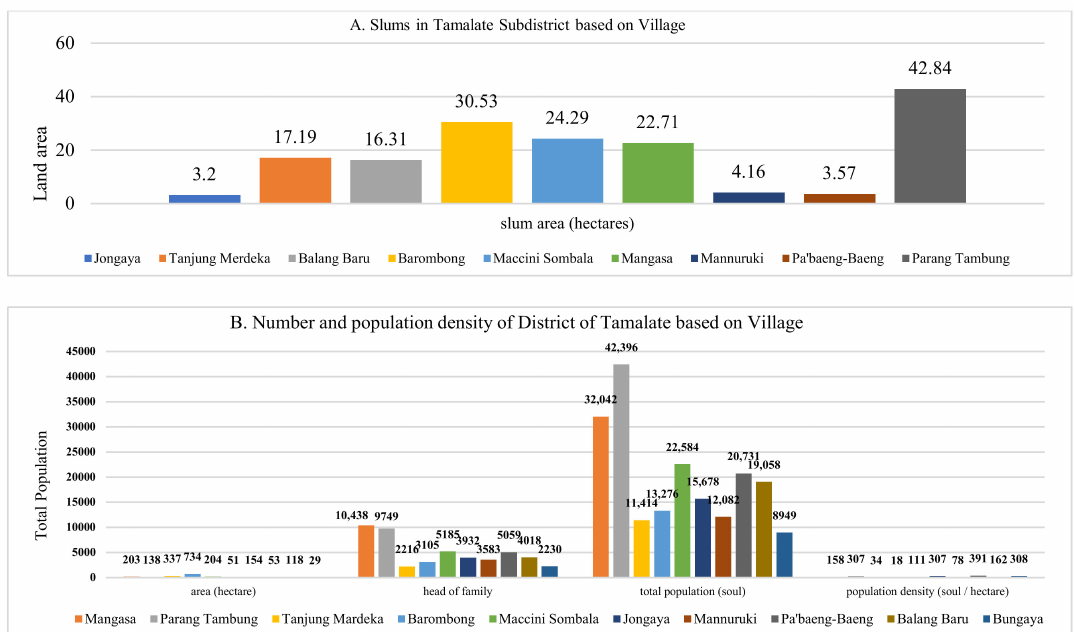
Figure 6. ( A ) Number of slum residents and ( B ) population density in the Tamalate District. [64]. Slums in the Tamalate subdistrict were distributed in nine villages. Here, we found that (i) the type of slum settlements consisted of lowland slums and covered an area of 4.16 hectares, at the edge of water covering an area of 117.8 hectares, and which is located on a river body covering an area of 42.84 hectares; (ii) the slums were categorized as moderate slums; (iii) the total area of slum settlements was 164.8 hectares; and (iv) the largest slum was Parang Tambung Village, occupying 42.84 hectares, and the smallest was Jongaya Village, with an area of 3.20